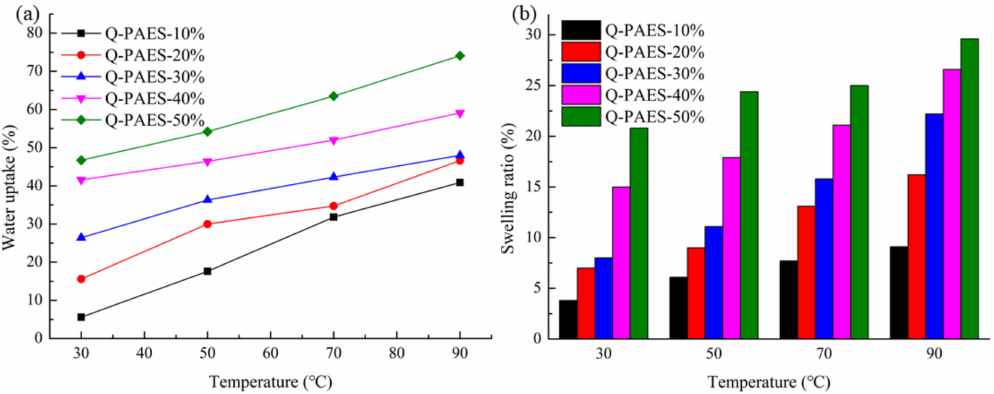
Figure 6. ( a ) Water uptake of fabricated membrane and ( b ) swelling ratio of